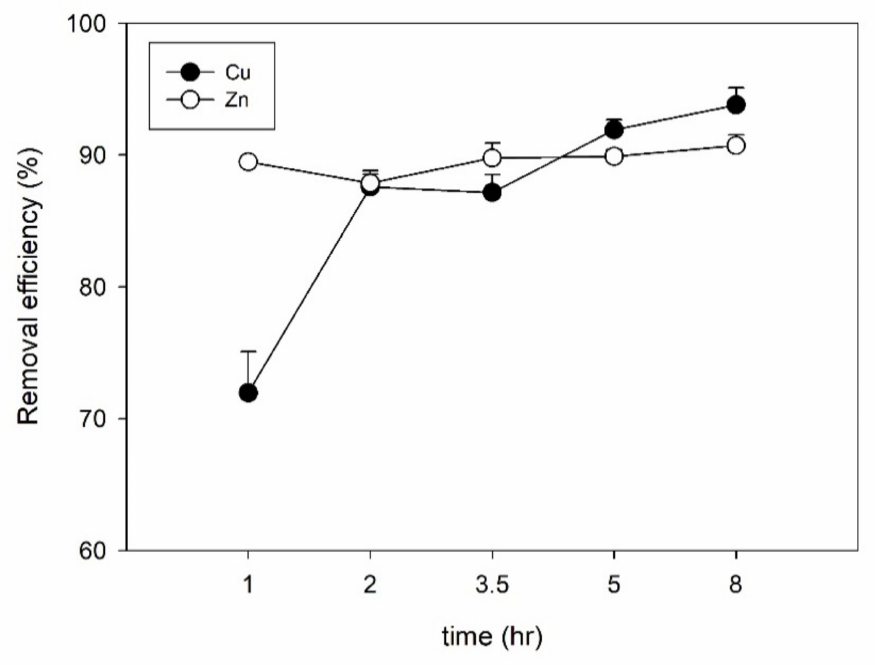
Figure 3. The influence of reaction time on removal efficiency of Cu and Zn from swine feces (concentration of H 2 SO 4 : 10%, solid to liquid ratio: